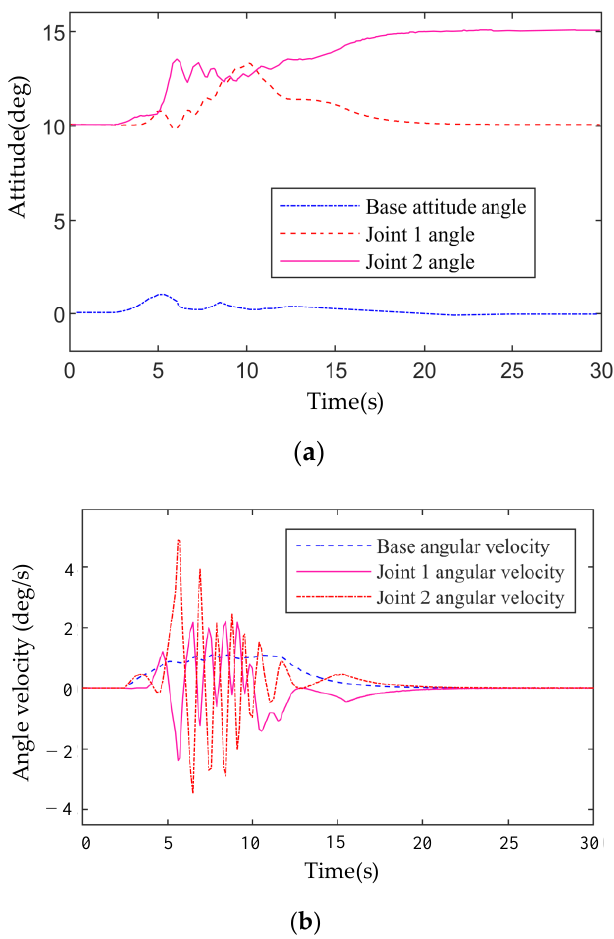
Figure 8. ( a ) The attitude of base and 2-DOF joints. ( b ) The angle velocity of base and 2-DOF joints.